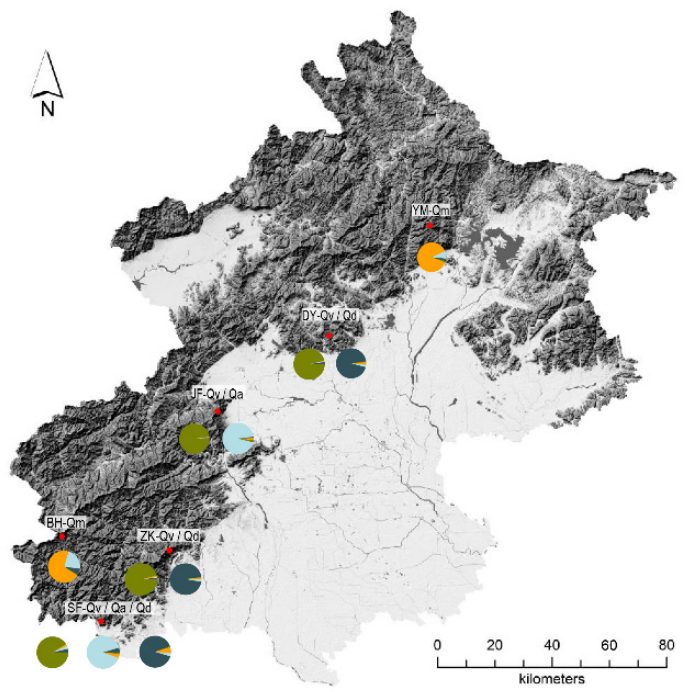
Figure 3. Population distribution map and genetic background of all samples. Different colors